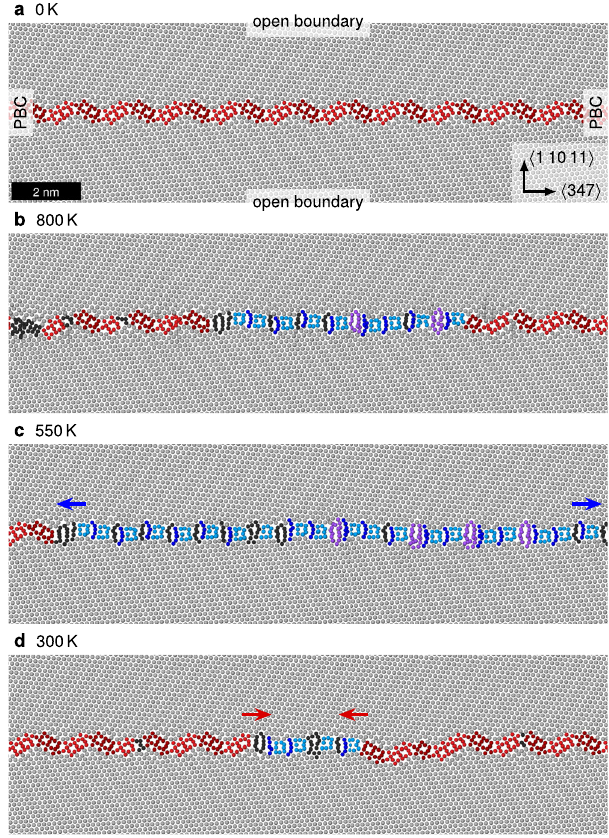
Fig. 6 Phase transition simulations. a We start from the domino structure with periodic boundary conditions (PBC) in the GB plane and open boundaries normal to it. b The pearl phase nucleates at 800 K and c keeps growing after reducing the temperature to 550 K (snapshot after 4 ns). The pearl structures contain many defects (disconnections, black). For a slowly cooled pearl sample with less defects see Supplementary Fig. 7. d Regrowth of the domino phase at 300 K observed after 2 ns for a system thickness of three atomic layers in tilt direction. All pearl phase disappeared after an additional 0.2 ns. The initial state was extracted from ( b ). All images are slices of width 1